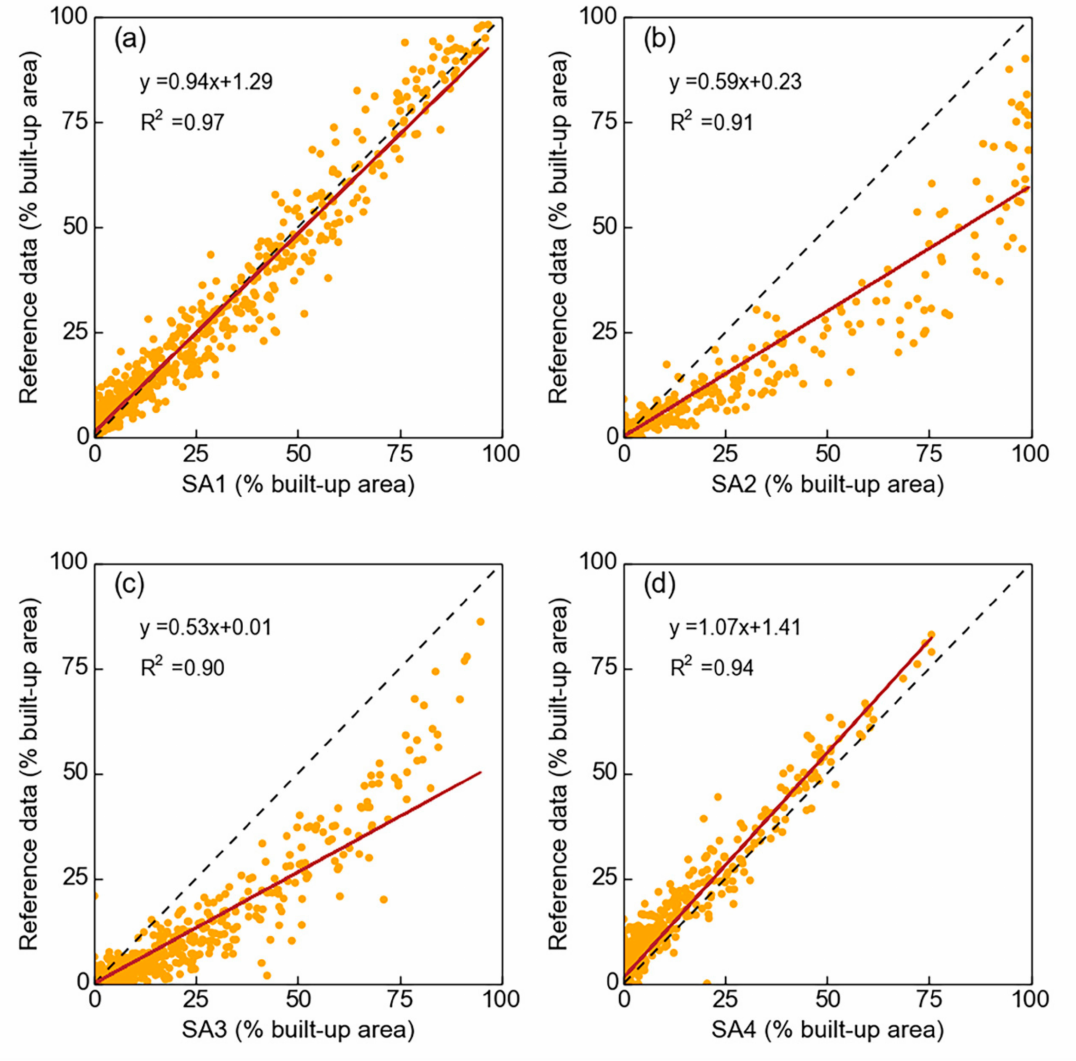
Figure 7. Built-up area scatterplots. The scatterplots compare the percentages of built-up areas in four study areas: ( a ) SA1 (Paris); ( b ) SA2 (Ankara); ( c ) SA3 (Madrid); and ( d ) SA4 (Lisbon) found by our method with the reference data in 9 km 2